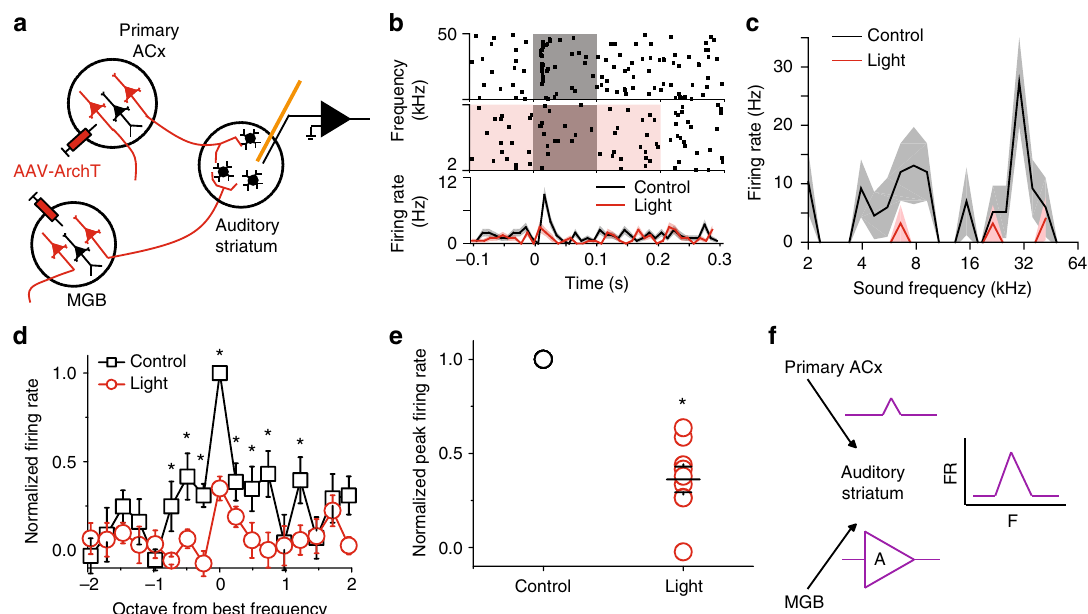
Fig. 5 MGB and primary ACx projections are the two major sources for striatal tonal response. a Illustration of recording setup for silencing both MGB and primary ACx projections. b One example of recorded MSN single unit. Upper panels, raster plots of a MSN fi rings during tone presentation (gray shaded area) and tone + light presentation (red + gray shaded area). Tone: 0 – 0.1 s time window; Light: − 0.1 to 0.2 s time window. Lower panel, PSTH of the fi ring rates in response to tone alone (black) and tone + light (red). c Tuning plots of the example shown in ( b ). d Average tuning plots at the tone alone (black) and tone + light (red) conditions. Frequencies are aligned to the best frequency of each single unit and scaled in octave away from the best frequency. The best frequencies are determined separately from control and light-on trials for each single unit. Firing rates at different frequencies of each single unit are normalized to the fi ring rate at the best frequency from control trials. e Normalized individual and averaged fi ring rates at best frequencies at the tone alone (black) and tone + light (red) conditions. For d , e , n = 9 neurons from two mice, data are presented as mean values, error bars are s.e.m., * p < 0.01, t test. f Proposed model of MGB and primary ACx contributions to striatal tonal